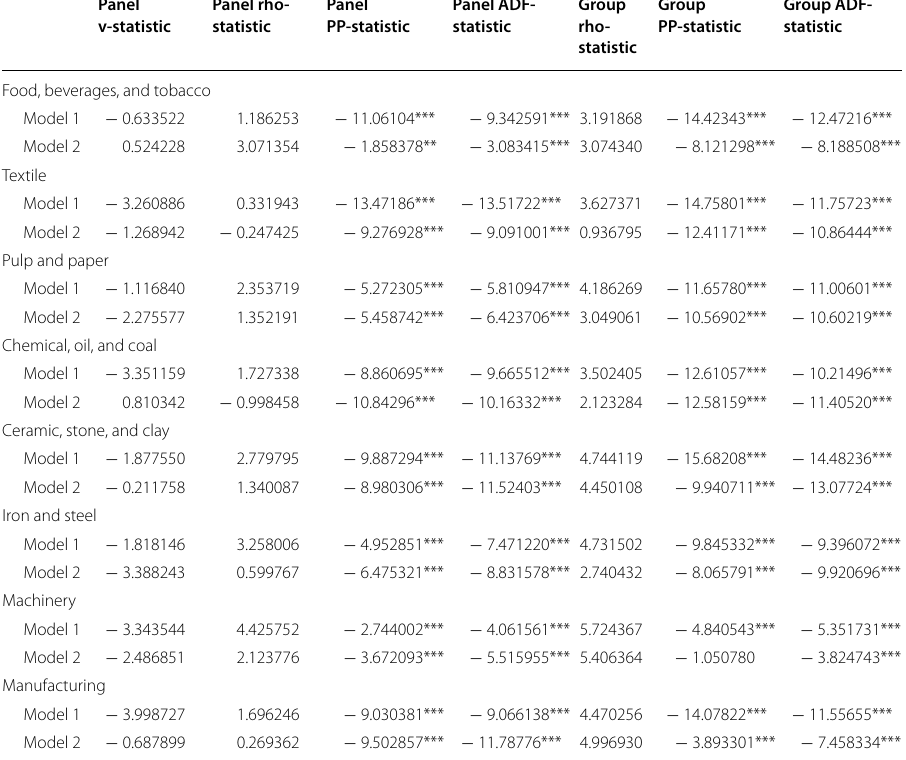
The test of the table selects the lag length based on the SIC and uses the nonparametric Bartlett kernel as well as the bandwidth based on the Newey–West method. The constants and trends are deterministic terms included in the tests ** p < 0.05 *** p <